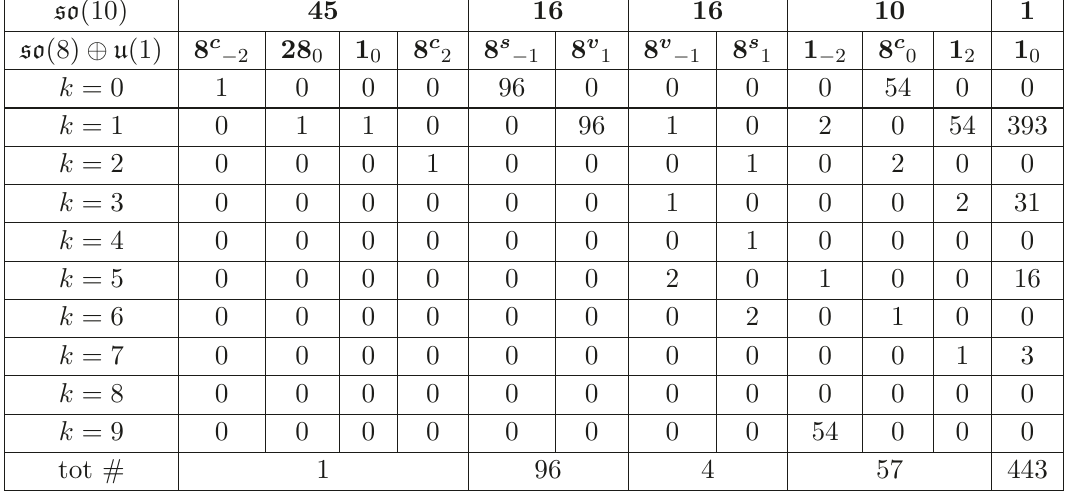
Table 2 . Summary of massless spectrum for the so (10)